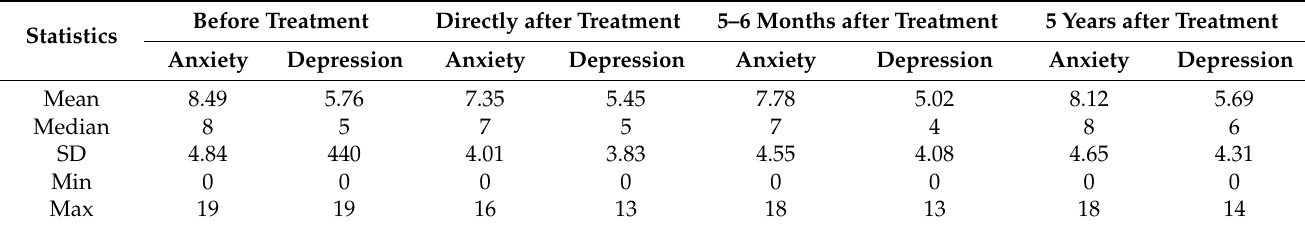
Table 9. Mean levels of anxiety and depression among respondents at different stages of the